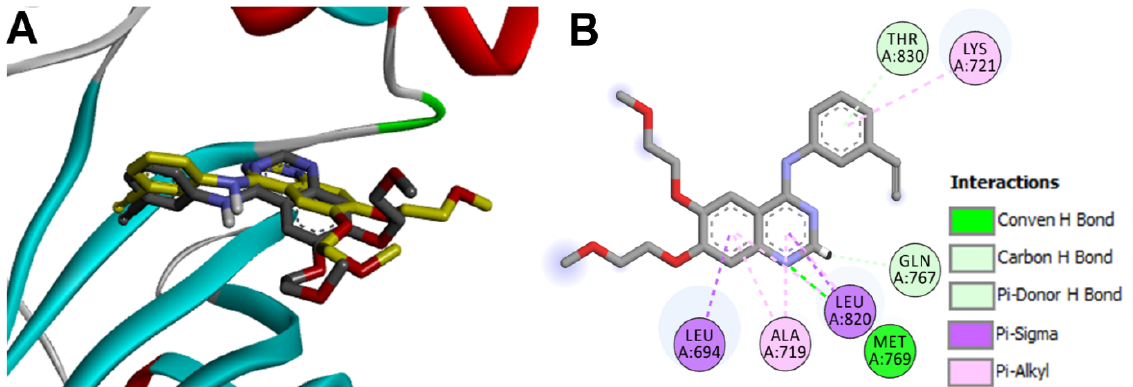
Figure 5. Binding mode/interactions of erlotinib (shown as sticks colored by element) into EGFR (pdb: 1M17): ( A ) 3D binding mode of the redocked erlotinib overlaid with the co-crystallized ligand (yellow sticks); ( B ) 2D binding mode of the co-crystallized erlotinib showing different types of binding interactions with amino acids in the active site of EGFR.